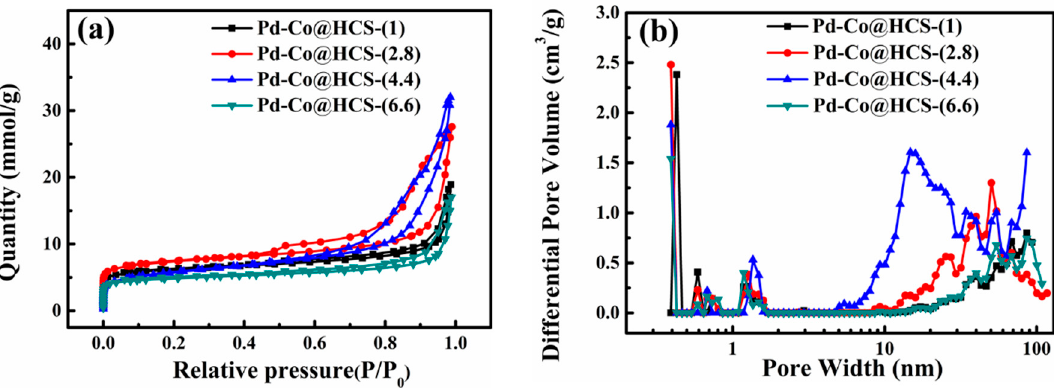
Figure 5. XRD patterns of Pd-Co@HCS-(X).